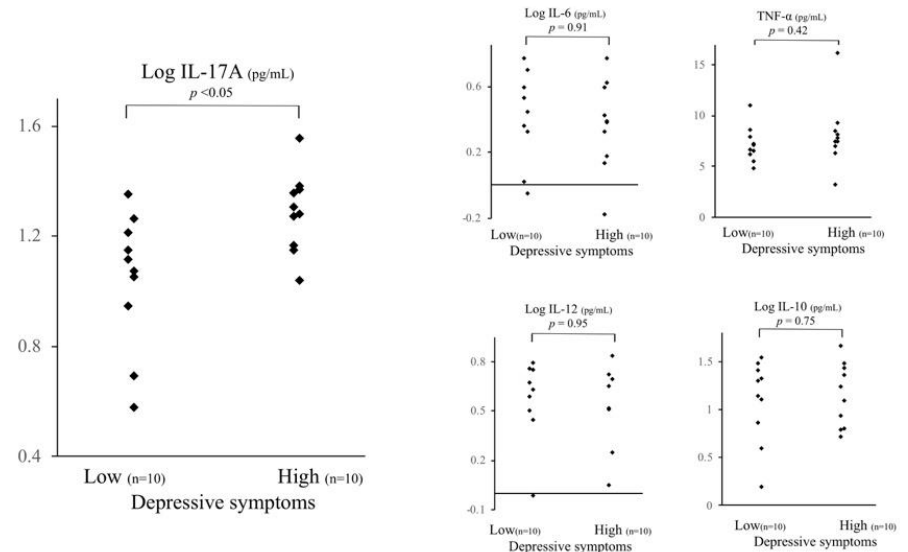
Figure 2. Comparison of serum cytokine levels between high and low depressive participants. The IL-17A serum level of high depressive participants was significantly higher than that of low depressive participants ( t test: p < 0.05, analysis of covariance: p < 0.05). There were no significant differences in other serum cytokine levels between the high and low depressive participants in the other serum cytokine levels, even adjusting for age and body mass index. Depressive symptoms were assessed using the Japanese version of the Centre for Epidemiologic Studies Depression Scale. * < 0.05, n.s. not significant.